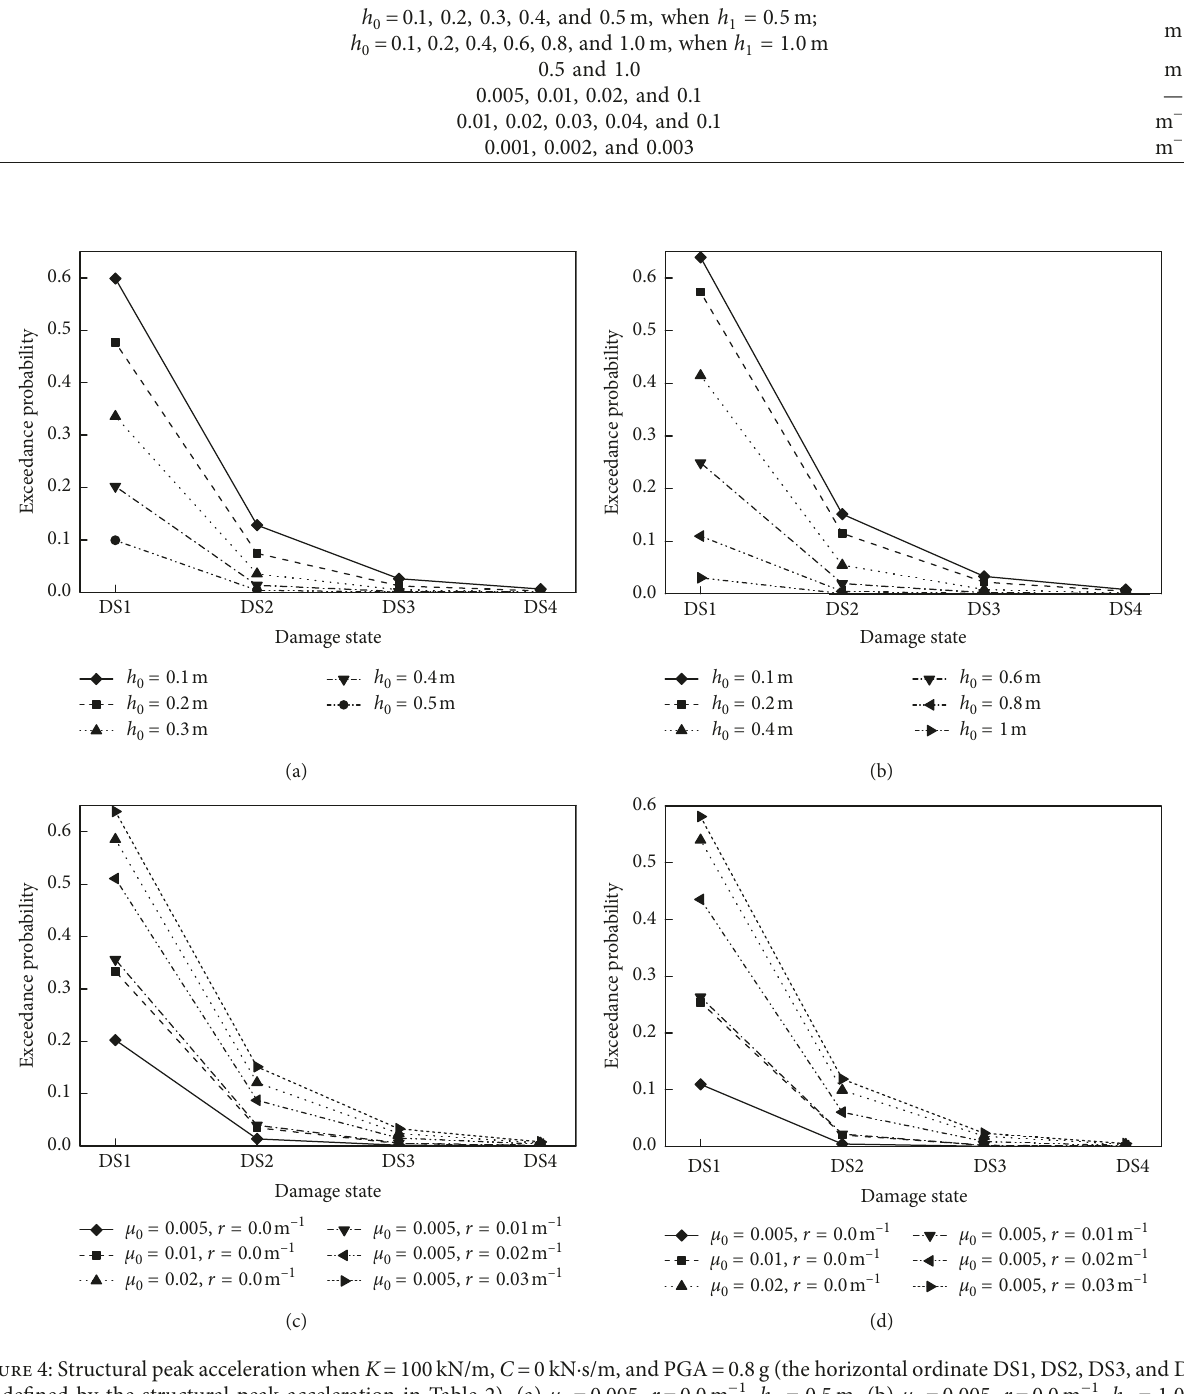
1 , h . 0m. 1 (cid:31) 1 −